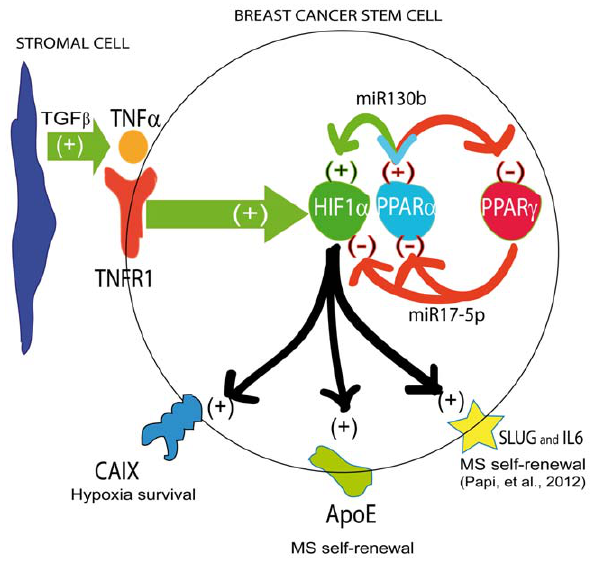
Figure 9. Schematic representation of the data. TAF secreted TGF b induces TNF a expression in breast CSCs. TNF a binds TNFR1 on breast CSCs and activates the PPAR a /HIF1 a interplay which up- regulates miR130b expression. The interplay is counterbalanced by PPAR c via miR17-5p up-regulation. In turn, the PPAR a /HIF1 a interplay regulates CAIX, ApoE, IL6 and SLUG